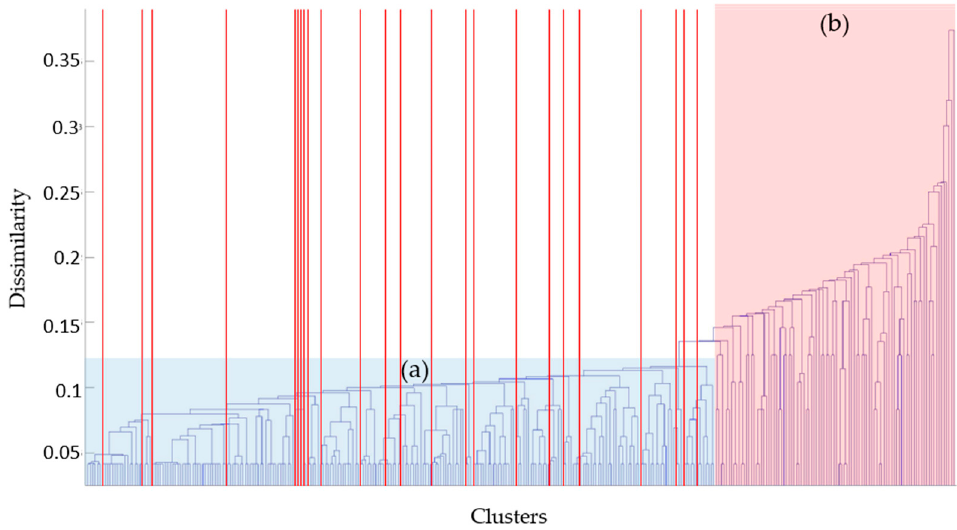
Figure 13. Clustering of 1:1 vessels and similar navigation situations: ( a ) a cluster group with a hamming distance of less than 2.3 from a 1:1 situation, ( b ) a cluster group with a hamming dis- tance of larger than 2.3 from 1:1 situation.